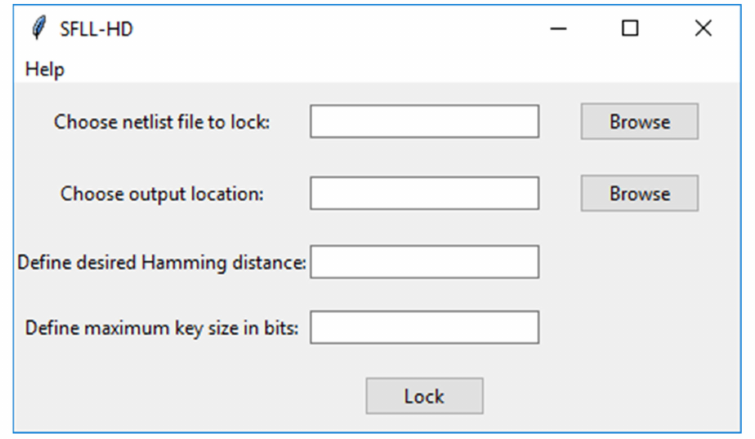
Figure 2. Graphical user